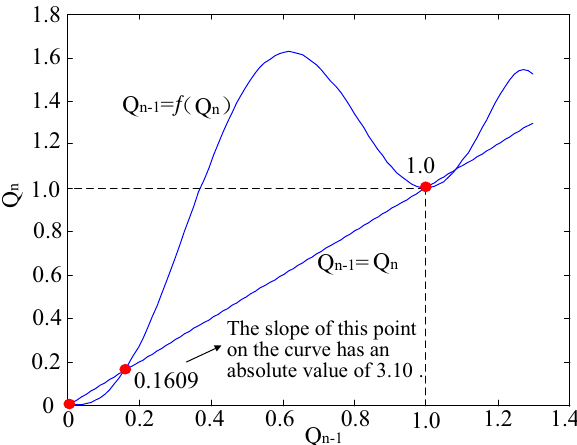
Fig. 8 Solution of the fixed points for the granule-centered regular hexahedron